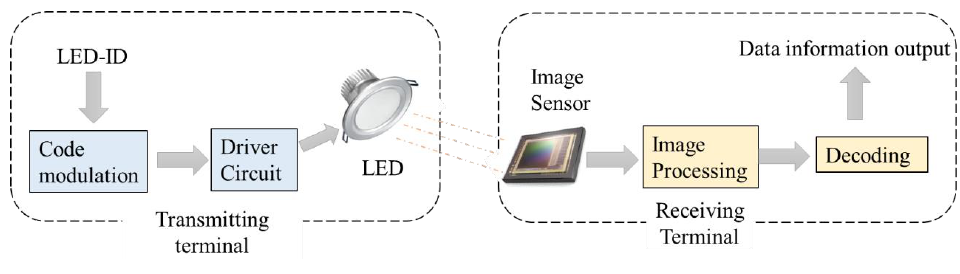
Figure 1. A common i-VLP system.